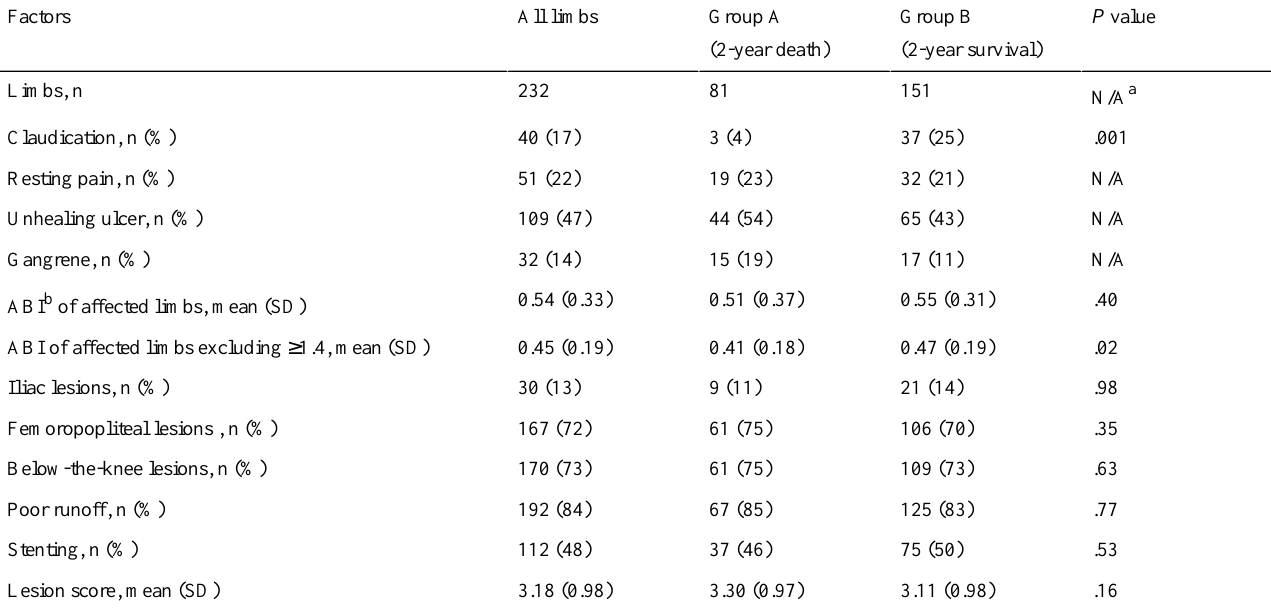
Table 2. Lesion and interventional procedure